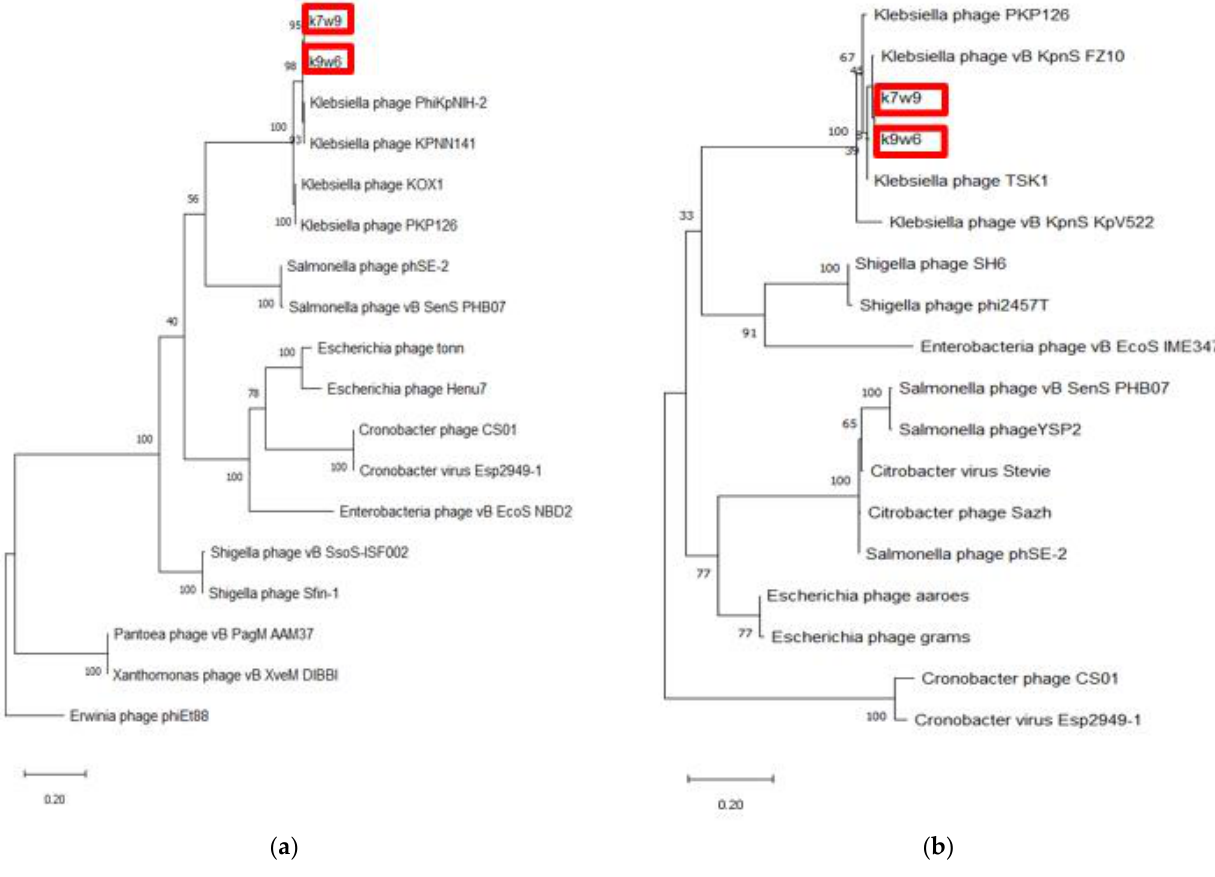
Figure 9. The phylogenetic tree of k9w6 and k7w9 the bacteriophage terminase large subunit and endolysin. The tree was constructed by using the maximum likelihood method with 2000 bootstrap replications. ( a ) The terminase large subunit of cronobacter bacteriophages was used as an out-group, ( b ) The Endolysin of Erwinia bacteriophage PhiEt88 was used as an out-group. The GenBank accession numbers are also provided after bacteriophage names, in parentheses. This tree showed the relationship of k9w6 and k7w9 terminase large subunit, endolysin with other close and distant bacteriophages.